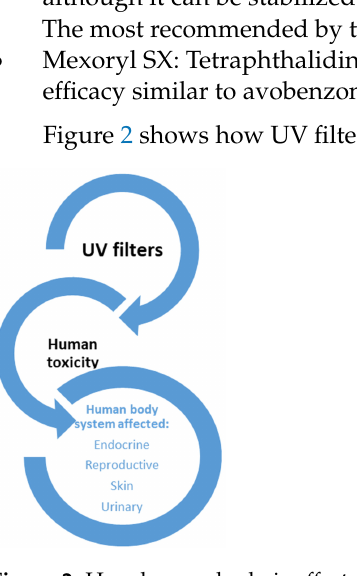
Figure 2. How human body is affected by UV filters. 3.1.3. Broad Spectrum Filters (UVA and UVB) In recent years, new filters have appeared that absorb, reflect, and scatter light, and are a hybrid between mineral and chemical filters. They have been created to avoid the